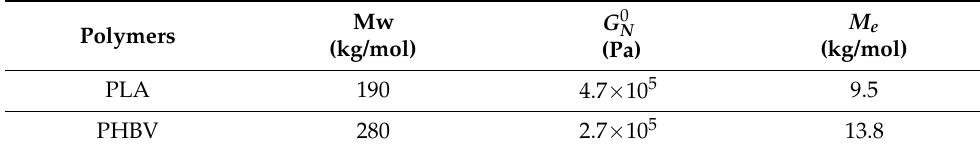
Table 7. Fundamental rheological parameters of PLA and PHBV at 175 ◦ C.